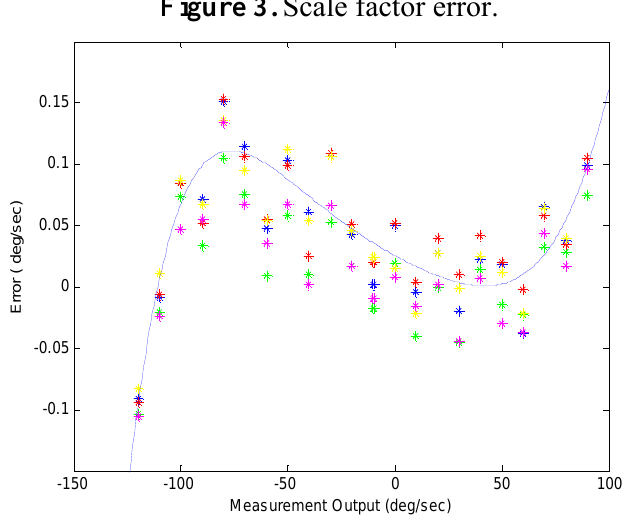
Figure 3. Scale factor